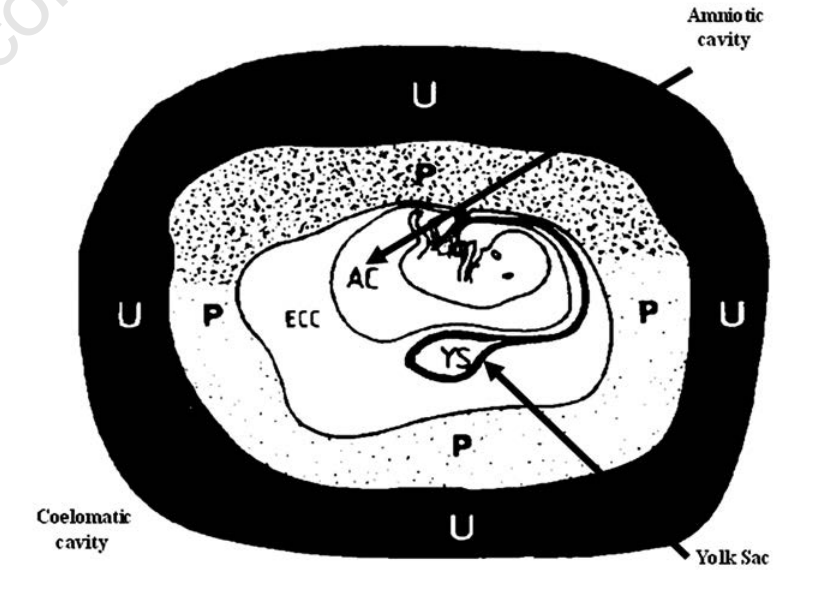
Figure 3. Coelomatic